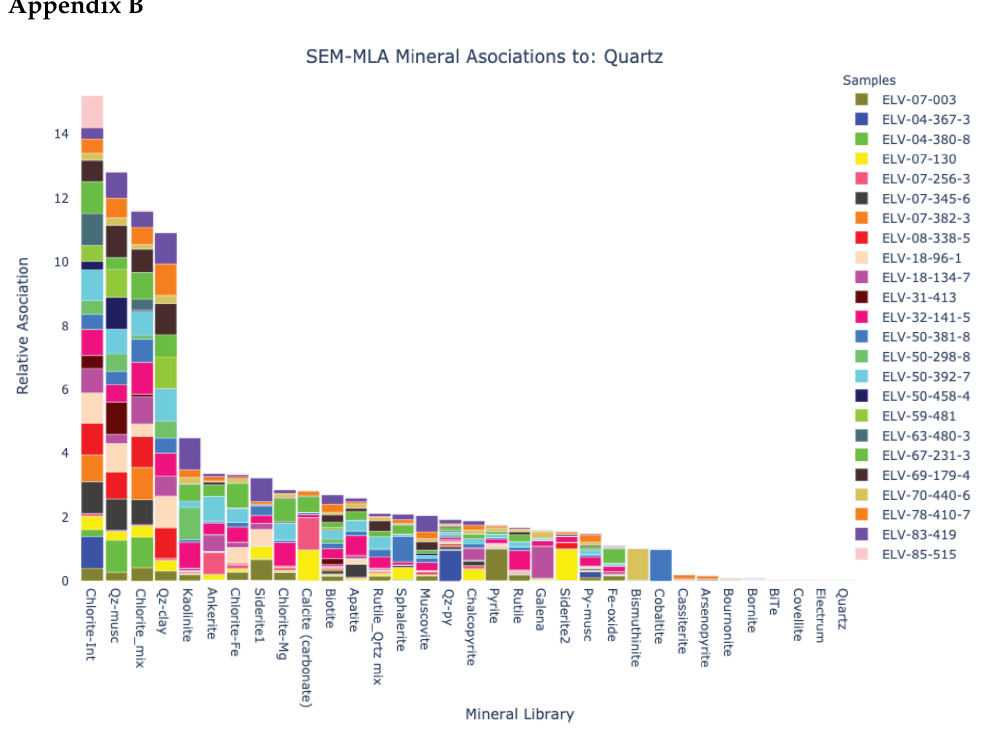
Figure A2. Mineral association to quartz from SEM-MLA samples. Based on 24 SEM-MLA samples from the Elvira deposit, a relative mineral association of Quartz was calculated. The association of a reference mineral A with another mineral B was calculated as the cumulative length of the contact between them normalized by the relative abundance of mineral B, both obtained from the same measurement with SEM-MLA [40]. This calculation is made for all minerals other than the reference mineral, in this case, quartz. The largest relative association obtained is with intermediate phases and mixtures of chlorite, muscovite, kaolinite and clays in